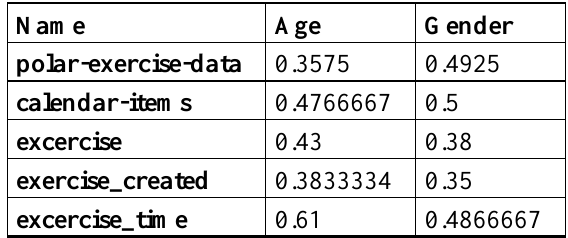
,N ) of concept name . s T